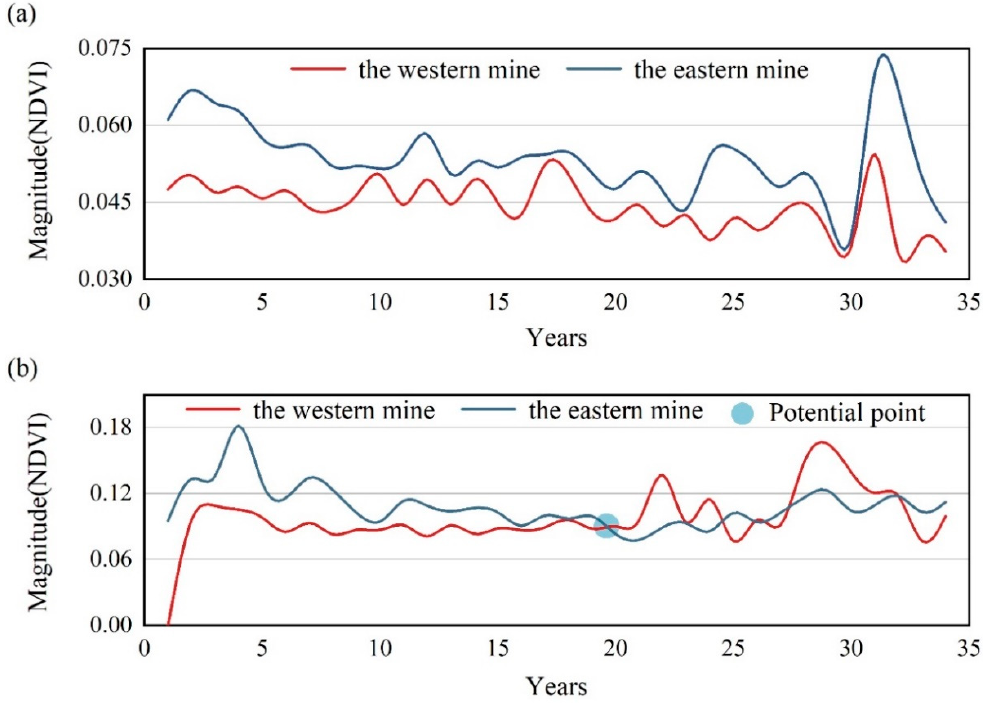
Figure 10. Trend of disturbance and recovery magnitude with duration. ( a ) disturbance; ( b ) recovery. Potential point: the duration point to reach natural fluctuation state.